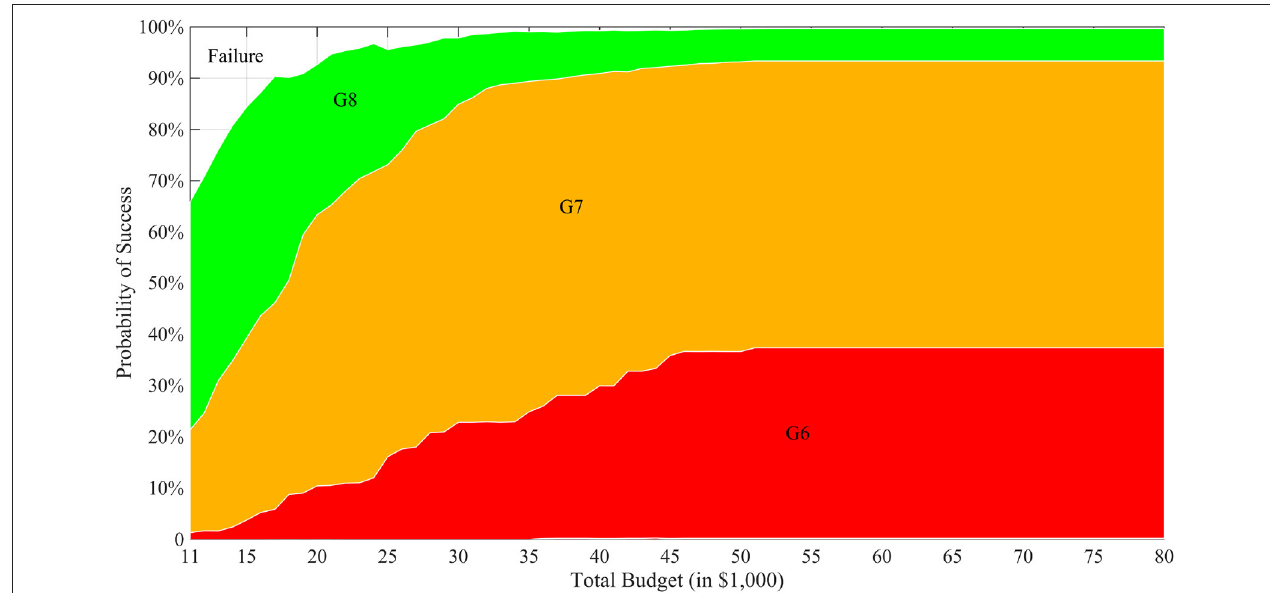
FIGURE 3 | CTP graph with T = 8. In the figure, the horizontal axis is different total budget scenarios of the breeding project and the vertical axis represents a stacked histogram of the probabilities of reaching success at different generations. In the figure, “G X ” label means that the breeding process successfully finishes in X generations and “Failure” means no ideal individual is produced when the budget or the time is